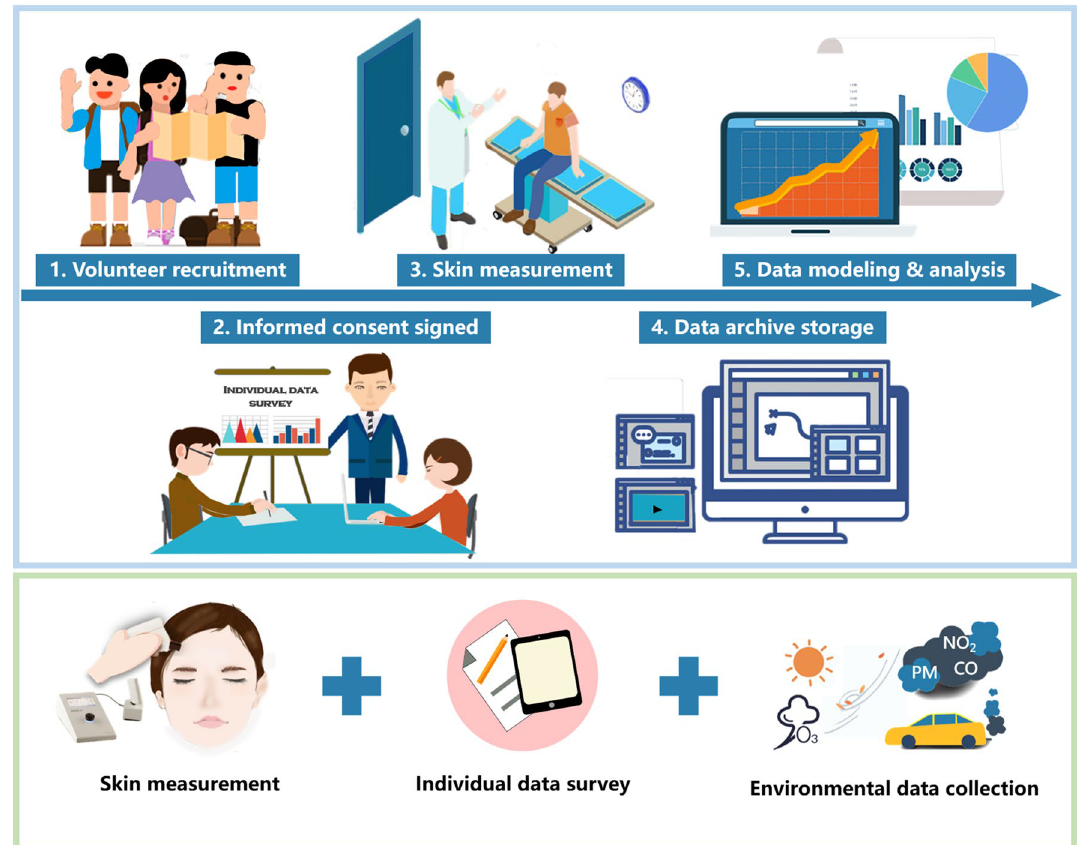
Figure 2. Research process of the multidimensional skin status